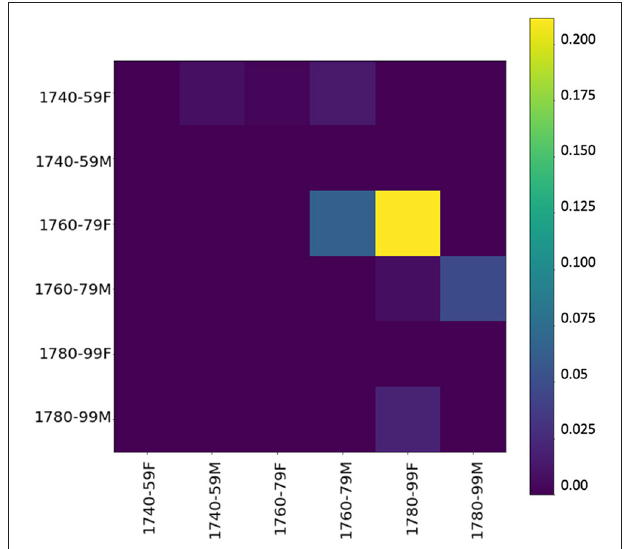
FIGURE 6 | Influencer heatmap of event cascades over time at the lexical level (500 most frequent